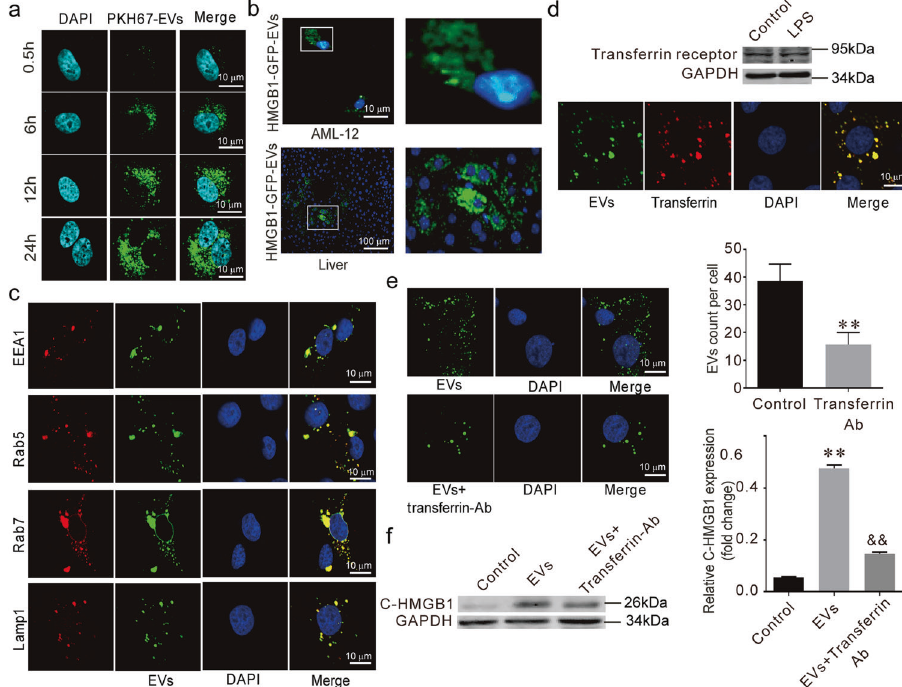
Fig. 4 EVs shuttle HMGB1 to AML-12 by transferrin-mediated endocytosis. a Representative confocal microscopy micrographs of AML-12 cells after co-culture with puri fi ed PKH67-EVs. b HMGB1-GFP EVs uptake occurred in vitro and in vivo. c The co-localization of internalized EVs and AML-12 endosomes (EEA1, Rab5, Rab7) or Lamp1. d The expression of transferrin receptor in EVs, the co-localization of internalized EVs with AML-12 transferrin. e The LPS-EVs absorbed by AML-12 cells. f Cytoplasmic HMGB1 in AML-12 cells. (**) P < 0.01 versus control group. ( ## ) P < 0.01 versus EVs